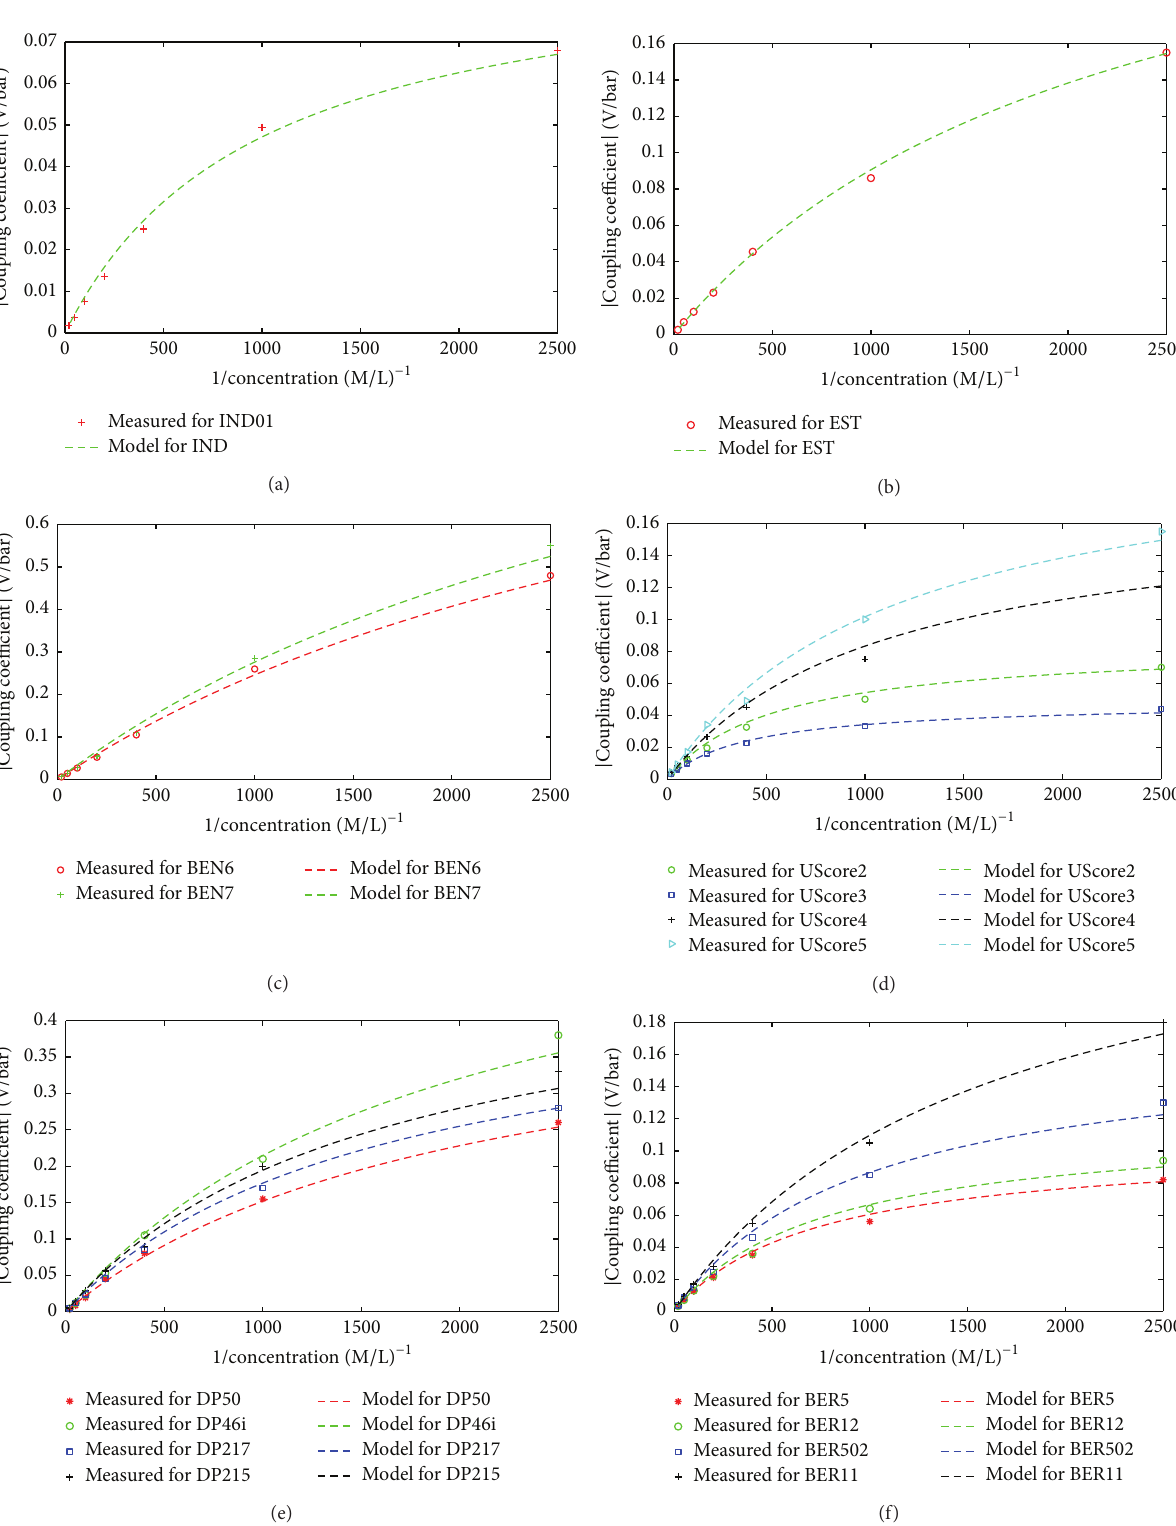
= 9.6 × 10 −28 S m 2 /site, (c) is for the Prot = 12 × 10 −28 S m 2 /site, (e) is for the Prot = 3 × 10 −28 S m 2 /site. The pH of 6.7 is used in Prot